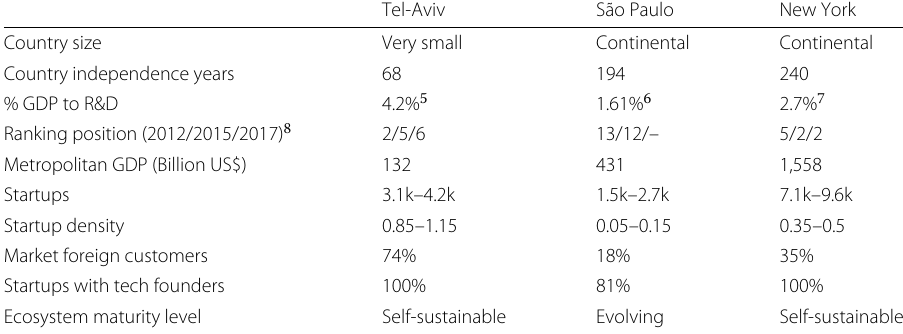
Table 1 Main differences across the Tel-Aviv, São Paulo, and New York startup ecosystems Tel-Aviv São Paulo New York Country size Very small